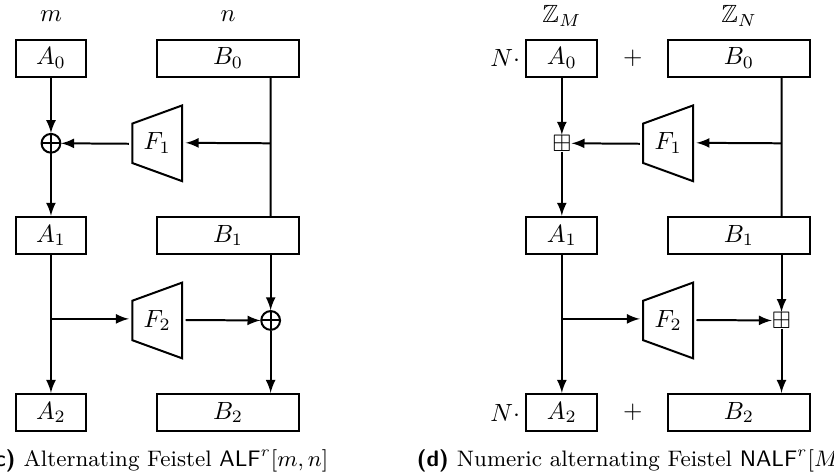
Figure 1: Unbalanced and alternating